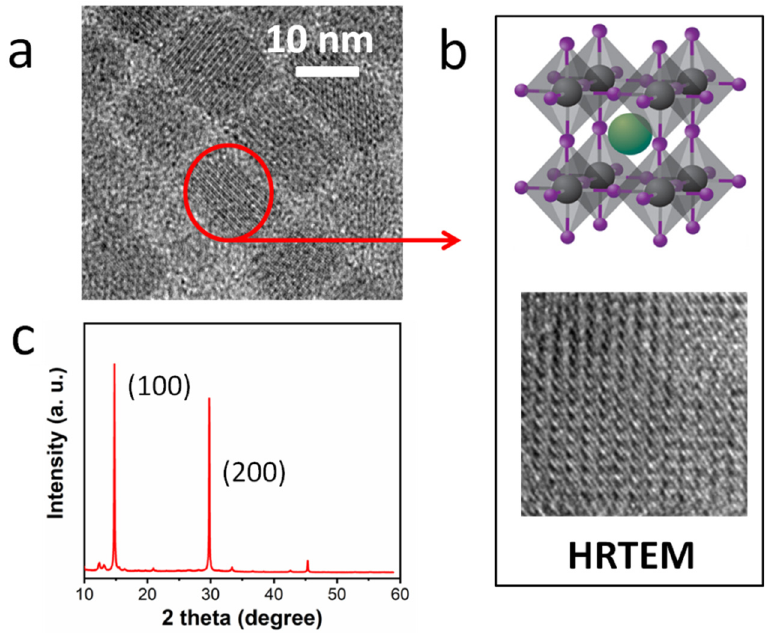
Figure 2. ( a )TEM image, ( b ) structure diagram and HRTEM images, ( c ) XRD patterns of perovskite QDs (FAPbBr 3 ).